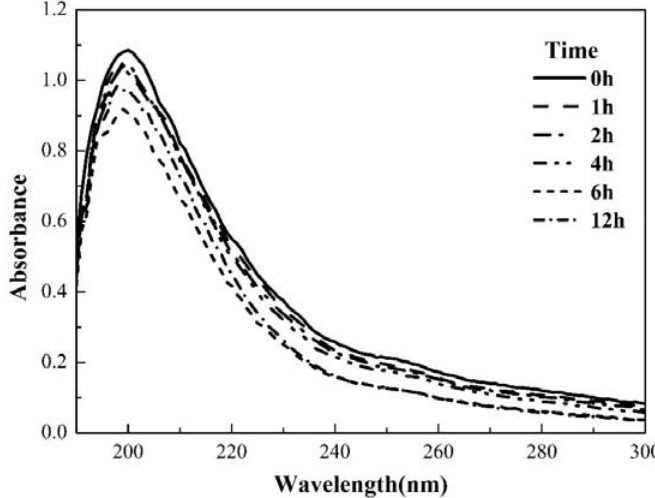
Figure 4. Biofilm EPS UV ‐ Vis absorption spectra during the ozonation process.